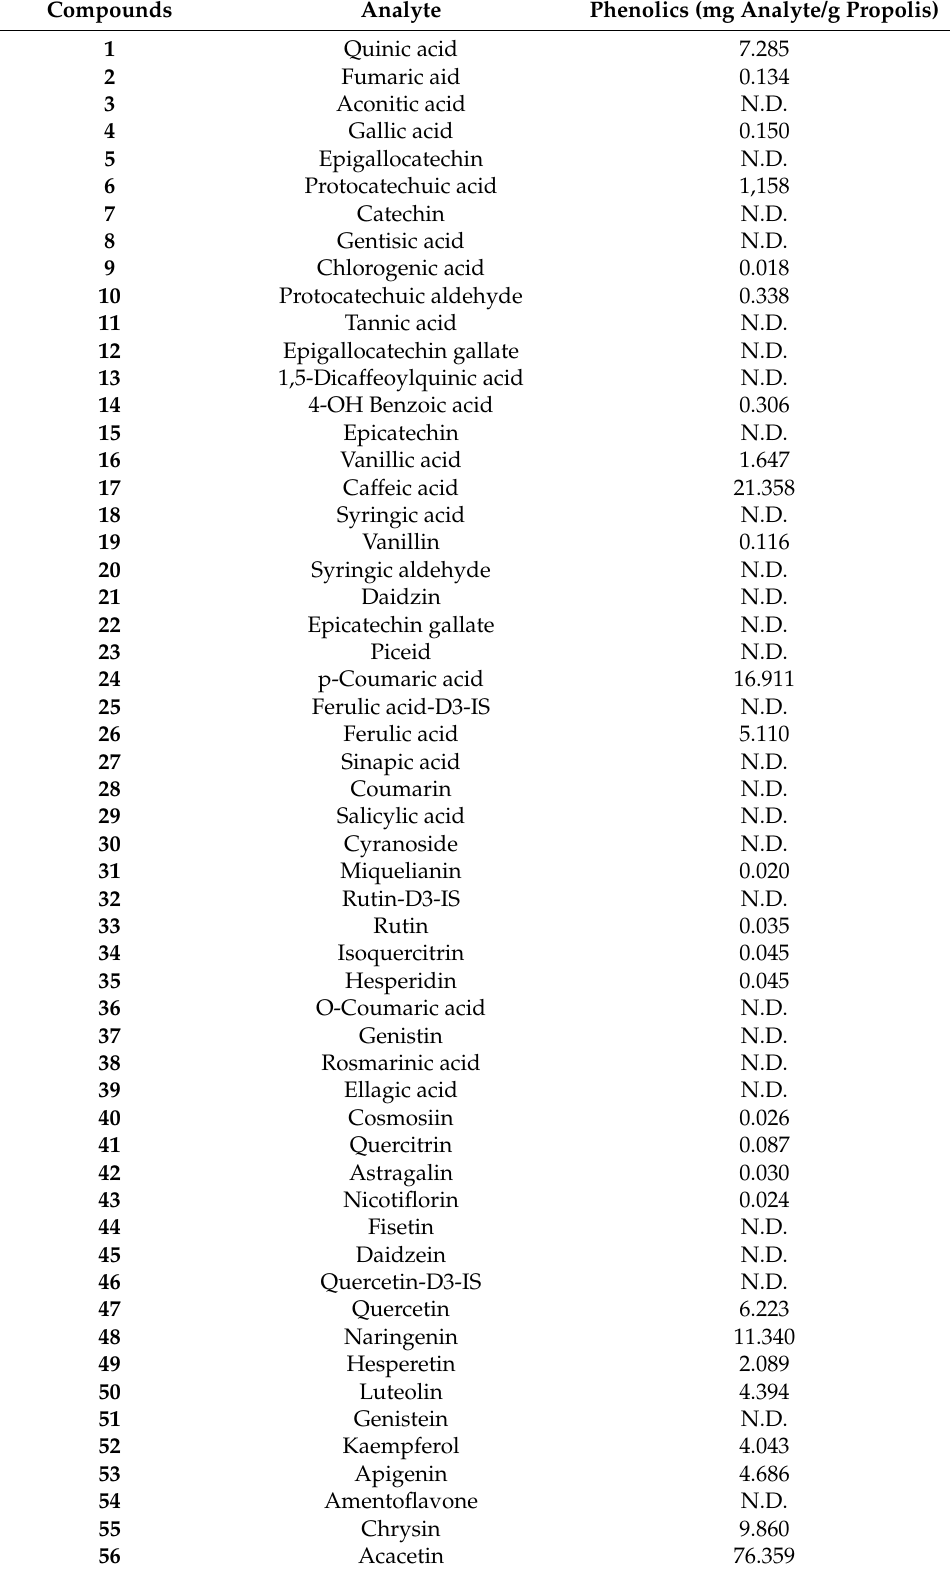
Table 2. LC–MS/MS parameters of selected compounds and amount of antioxidants in propolis in mg/g